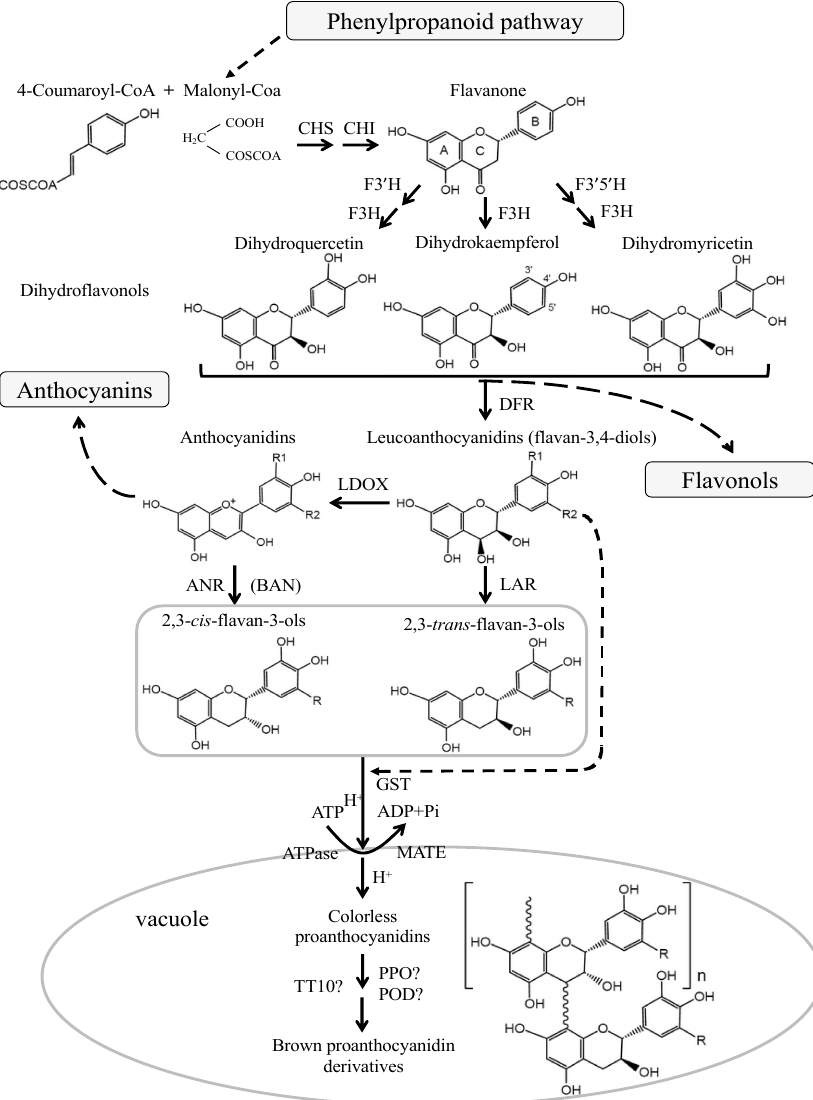
Figure 2. Biosynthetic pathway of flavonoid (adapt from [1,38]). The enzymes are: CHS, chalcone synthase; CHI, chalcone isomerase; F3H, flavanone 3-hydroxylase; F3 ′ H, flavonoid 3 ′ -hydroxylase; F3 ′ 5 ′ H, flavonoid 3 ′ ,5 ′ -hydroxylase; DFR, dihydroflavonol-4-reductase; LAR, leucoanthocyanidin reductase; ANS, anthocyanidin synthase; LDOX, leucoanthocyanidin dioxygenase; GST, glutathione S-transferase; MATE, multidrug and toxic compound extrusion; PPO, polyphenol oxidase; POD, peroxidase; TT10, transparent testa 10.